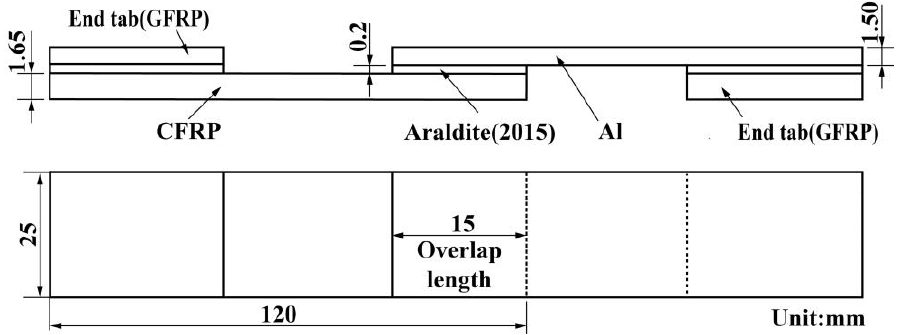
Figure 1. Geometry of CFRP – Al single-lap adhesive joints.